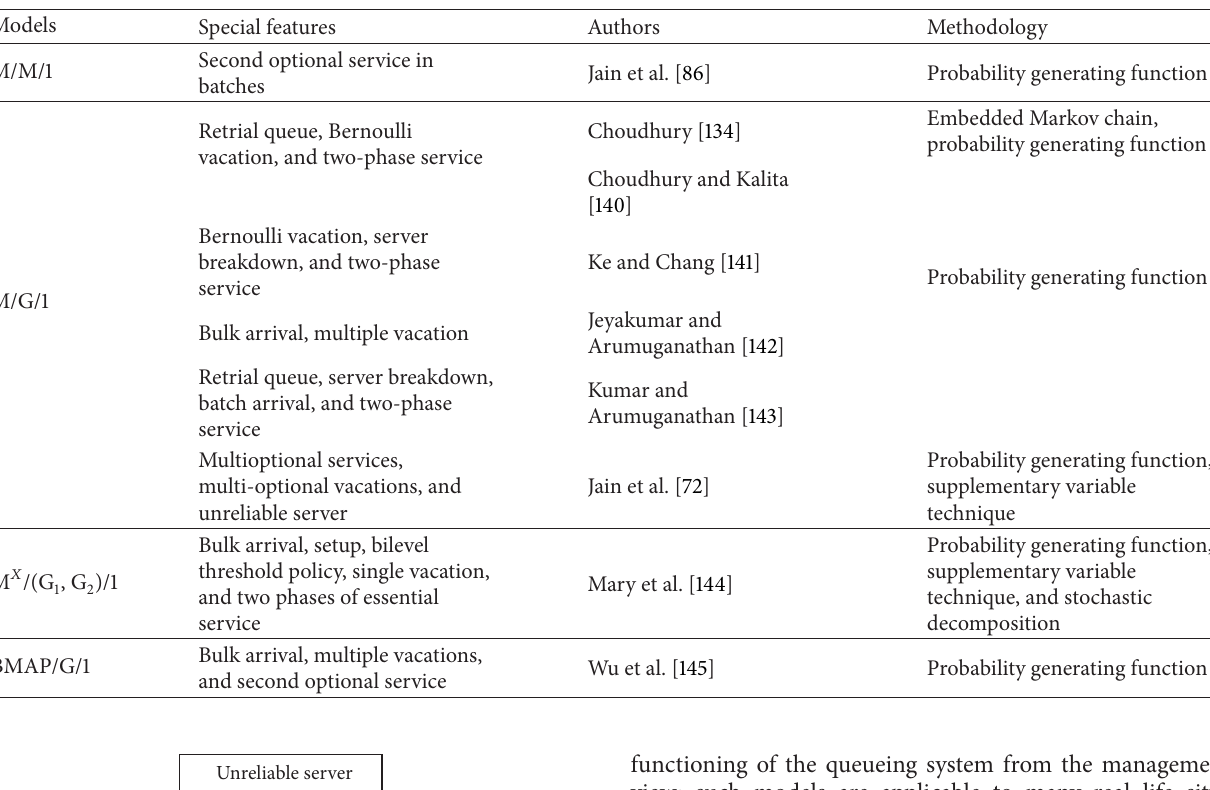
Table 3: Literature on vacation queue with phase service.